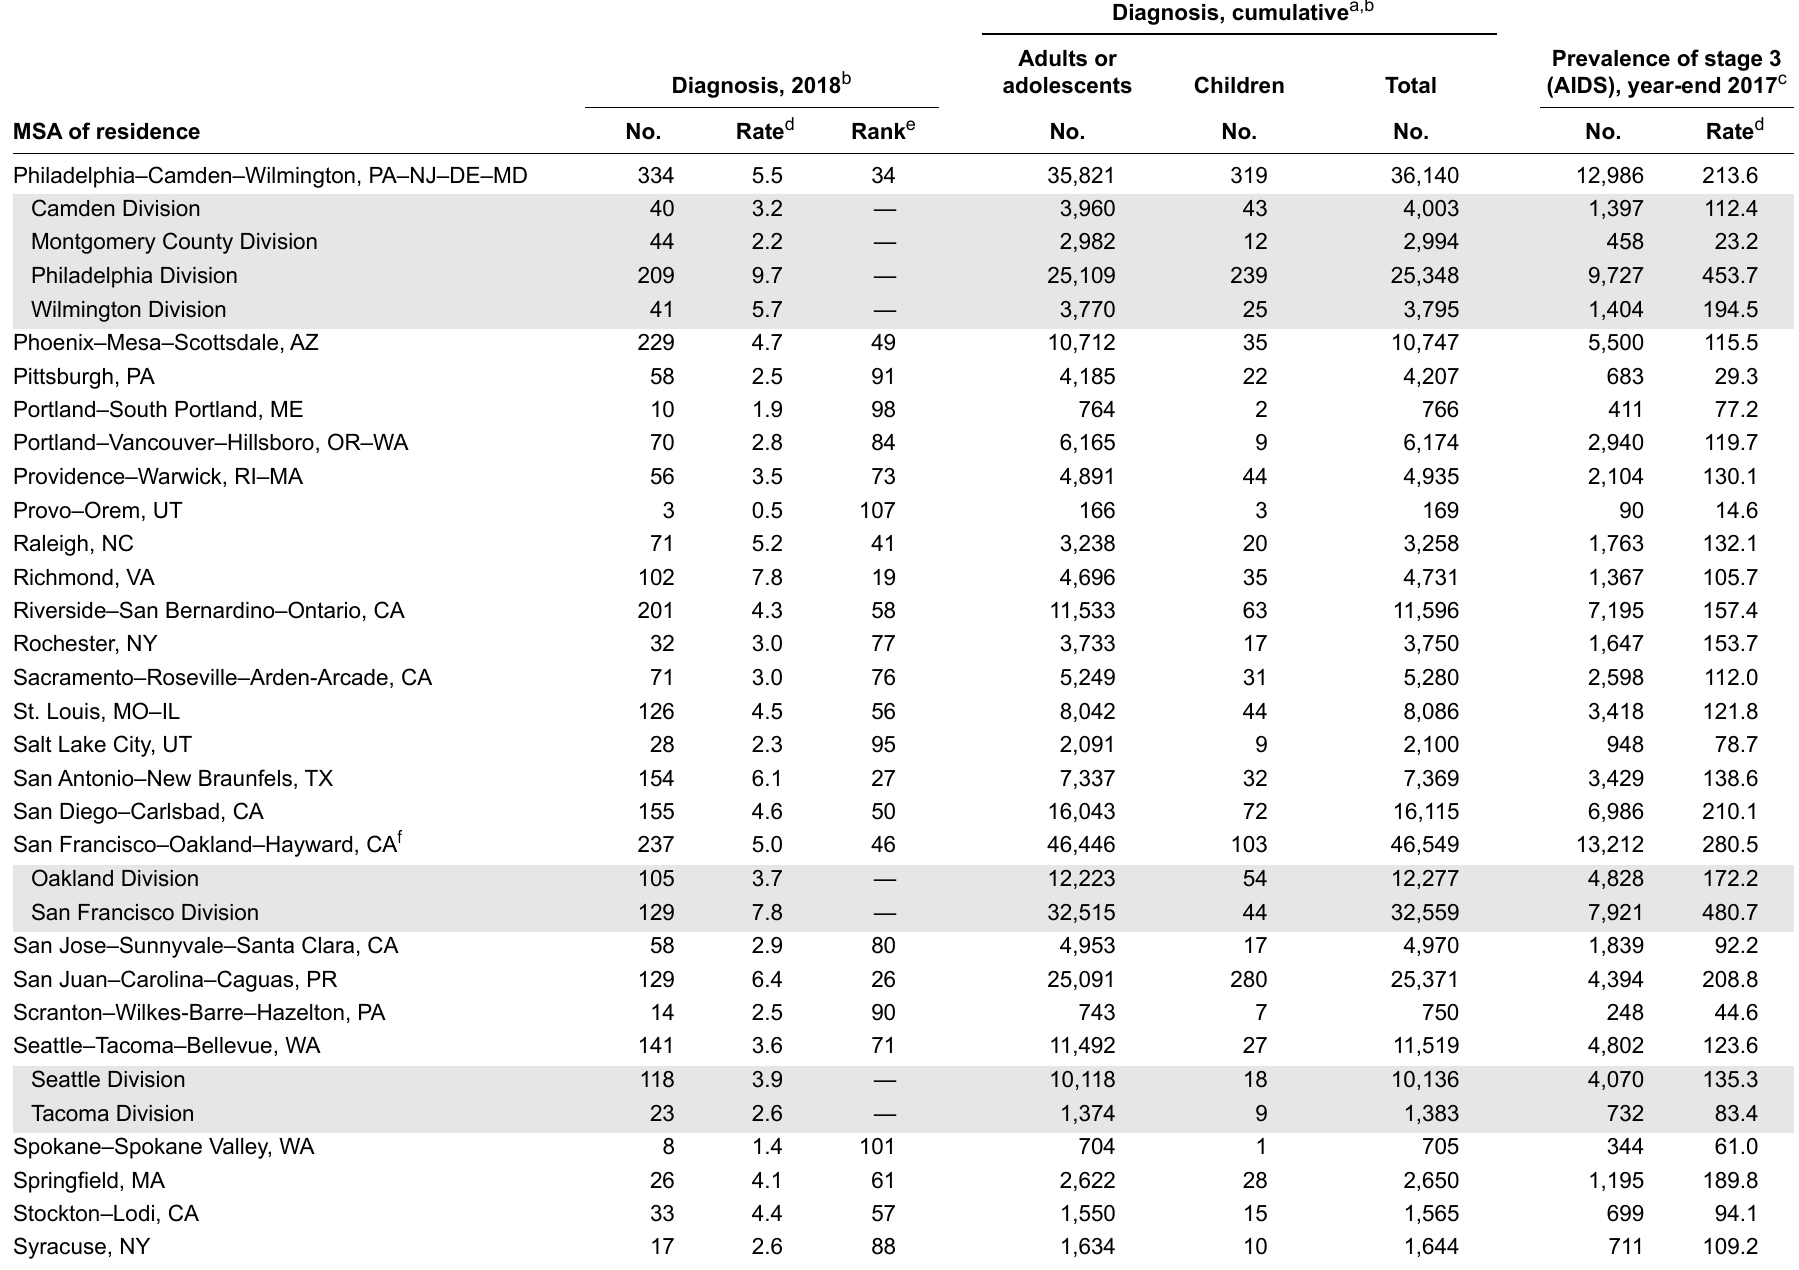
Table 31. Stage 3 (AIDS), 2018 and cumulative, and persons living with diagnosed HIV infection ever classified as stage 3 (AIDS) (prevalence), year-end 2017, by metropolitan statistical area of residence—United States and Puerto Rico